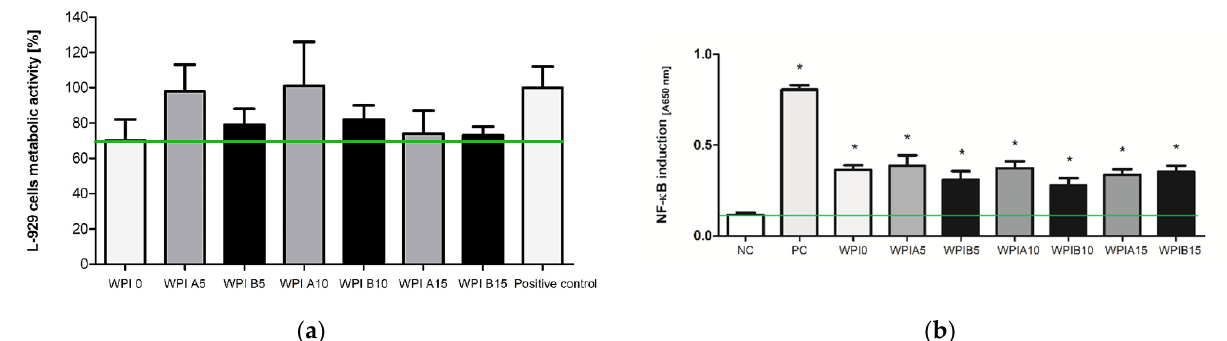
Figure 10. ( a ) The viability of murine fibroblasts L-929 after 24 h incubation with WPI modified HAp A and HAp B biocomposites, evaluated using the 3-(4,5-dimethylthiazol-2-yl)-2,5-diphenyltetrazolium bromide (MTT) reduction assay according to ISO-10993-5:2009. The cells incubated without composites served as a positive control of the viability (100%). The data are presented as mean ± SD for the three separate experiments. The green line indicates the minimum level (70%) of the cells’ metabolic activity required to recognize the biomaterial as non-cytotoxic at the in vitro level; ( b ) NF-κB induction in THP1-Blue™ monocytes incubated for 24 h with WPI modified HAp A, and HAp B biocomposites. The cells incubated without composites served as a negative control of the monocyte’s activation (NC), and monocytes stimulated with S. cerevisiae β-glucan served as the positive control (PC). The data are presented as the mean ± SD for the four separate experiments. The green line indicates the physiological level (0.114 ± 0.013) of the non-stimulated monocytes. * p values (<0.05) calculate in comparison to the untreated cell cultures.